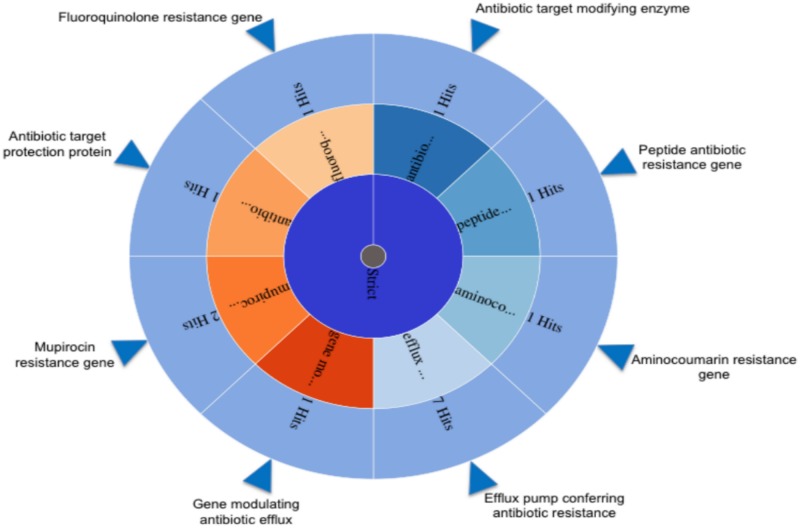
Screening of the whole genome of Lactobacillus pentosus MP-10 by using the perfect and strict algorithms in the Resistance Gene Identifier (RGI) with overall resistance in the center, resistance classes in the middle, and individual resistance genes on the outer (open reading frames).